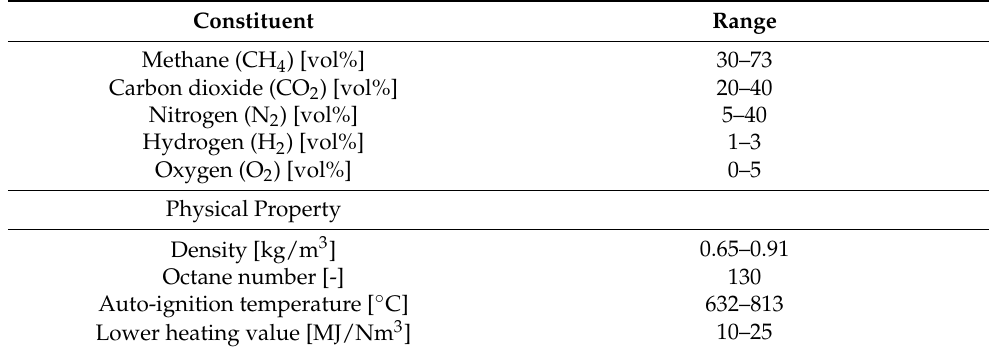
Table 1. BG composition and